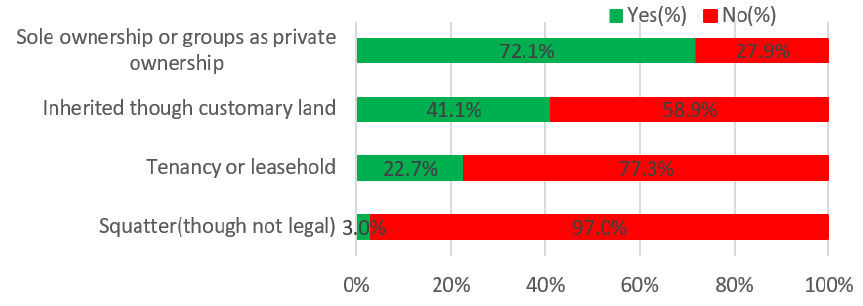
Figure 6. Land tenure